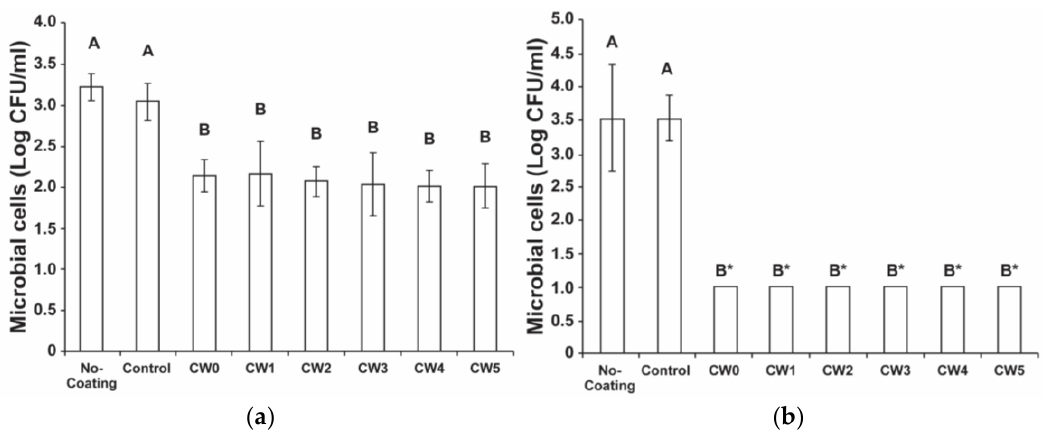
Figure 8. Survial of E. coli O157:H7 on the surface of metal disks. Sample disks under light for 3 h ( a ) and 18 h ( b ). No-coating: a disk wihout any coating; Control: coated disk without TiO 2 ; CW0-5: Disk coated with codoped-TiO 2 being washed in water for 0 to 5 times; *: under detetable level (<1.0 log/CFU); Error bars represent the standard deviation of the mean; Data having a common letter are not significantly different ( p > 0.05).